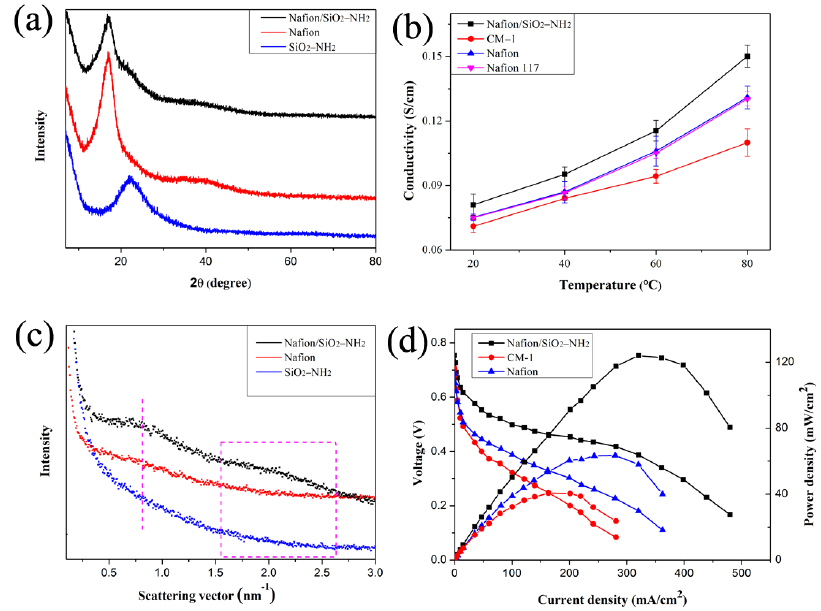
Figure 5. ( a ) XRD curves of Nafion, Nafion/SiO 2 – NH 2 and SiO 2 – NH 2 ; ( b ) Proton conductivity curve, ( c ) SAXS curves and ( d ) DMFC performance (operated at 40 °C and 100% RH) of Nafion/SiO 2 – NH 2 , Nafion and CM-1.